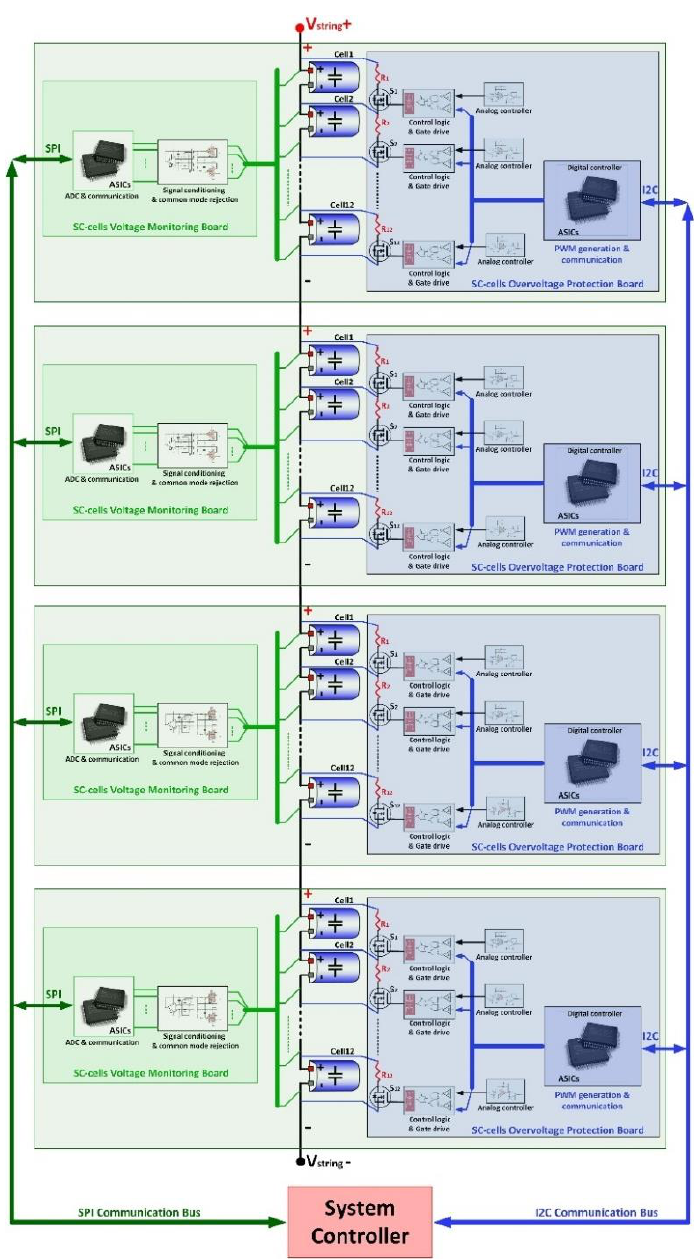
Figure 6. Block diagram for the full architecture of the proposed SC-ESS.